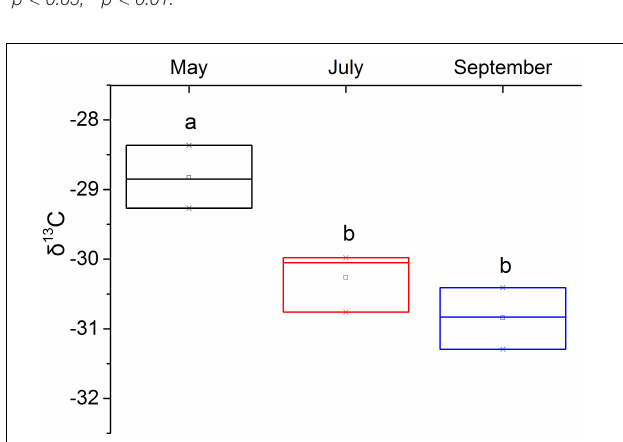
FIGURE 2 | Seasonal variation characteristics of δ 13 C in leaves of M. sibirica.